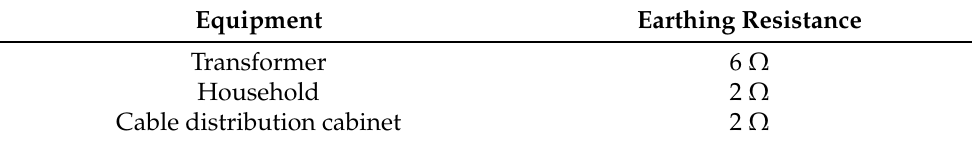
Table 1. Earthing resistances from [44].